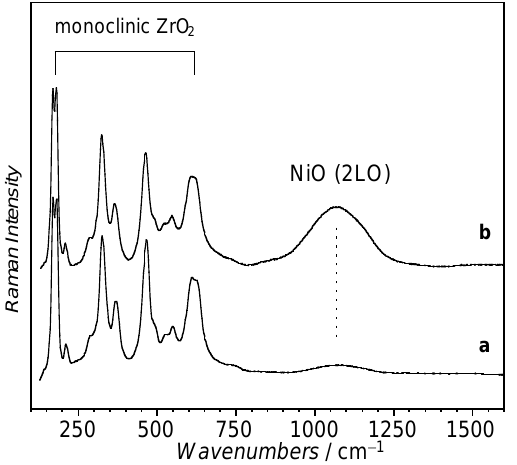
Figure 3. Raman spectra of catalyst precursors. ( a ) 4.8NiO/Z hy ; ( b ) 5.1NiO/Z m . Temperature-programmed reduction (TPR) was applied to study the reducibility of NiO species, which is expected to depend on the strength of interaction with the